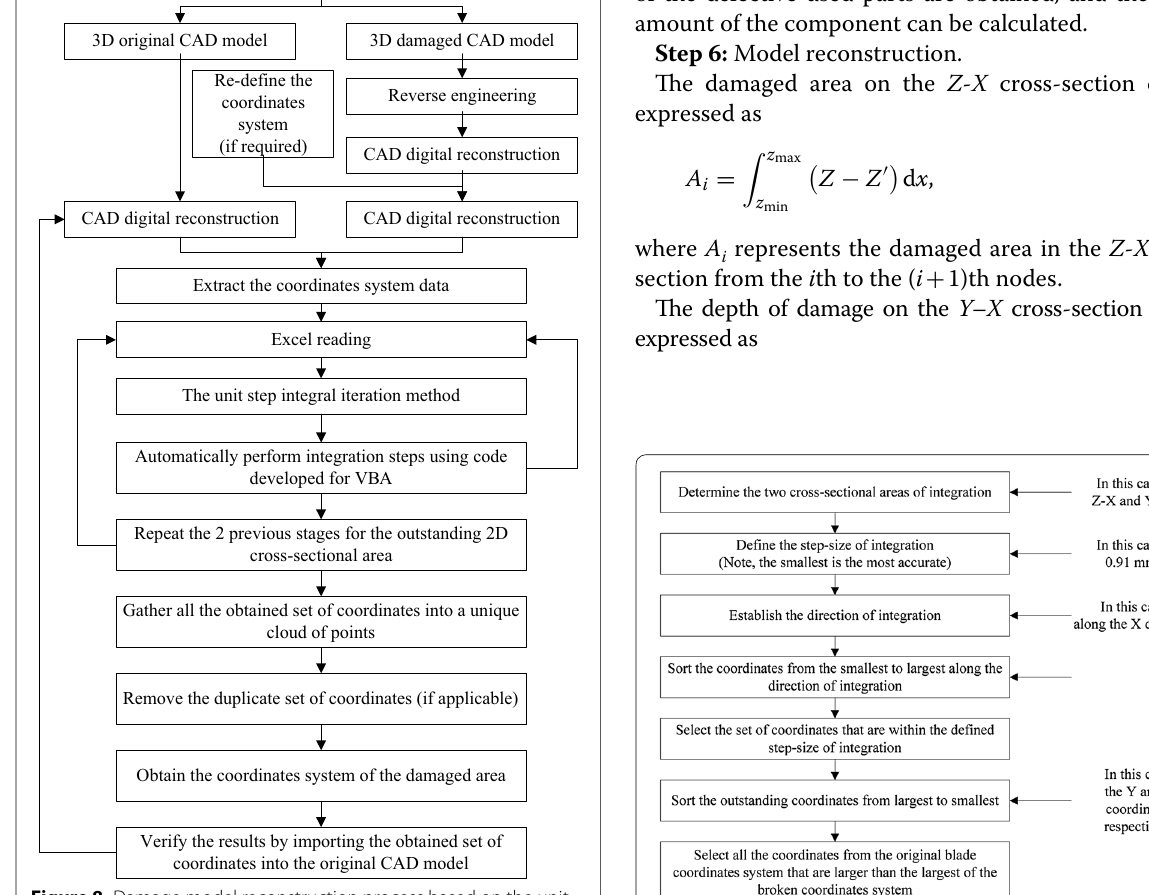
Figure 8 Damage model reconstruction process based on the unit step integral iteration method Figure 9 Integral iterative